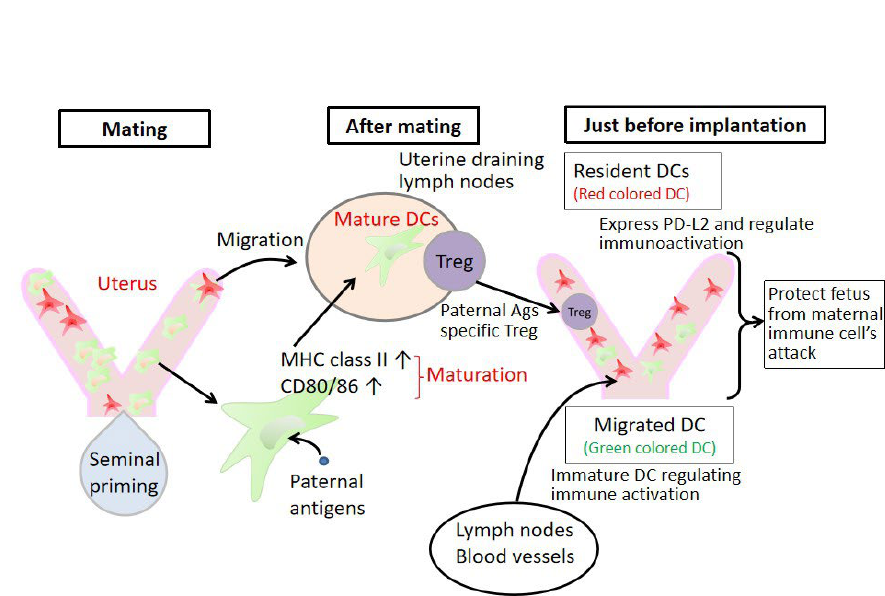
Figure 1. Dynamic changes in the phenotype of uterine DCs. We looked at the migration of DCs using KikGR mice. When the uterus is irradiated with UV light, the cell’s color in the uterus turns red. The DCs that migrated from the uterus to other organs afterwards showed red color, which could be identified as DCs originating from the uterus. On the other hand, DCs that have entered the uterus from outside the uterus present a green color and can be distinguished. Using this experimental system, it was presumed that after sexual intercourse, DCs in the uterus mature and increase their antigen-presenting ability. They migrate to the uterine regional lymph nodes and induce paternal antigen-specific Tregs. In addition, some DCs remain in the uterus and express programmed cell death 1 ligand 2 (PD-L2), which contribute to immunoregulation. DCs that enter the uterus from outside the uterus are immature-immunosuppressive DCs. These fine mechanisms allow the fetus to escape the attack of immune cells from the